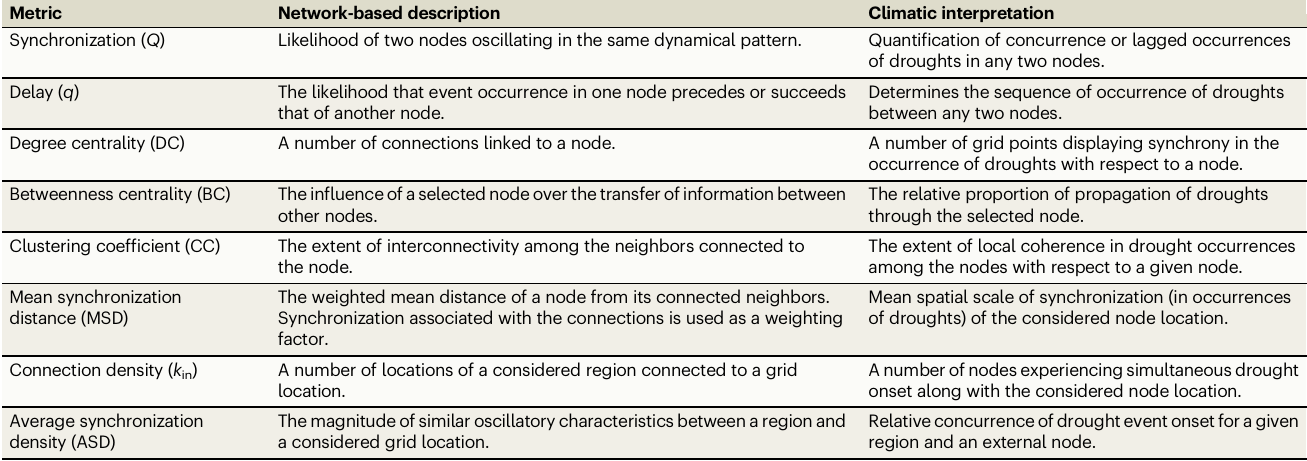
Table 1 | Complex network-based metrics used in the study and their climatic interpretation